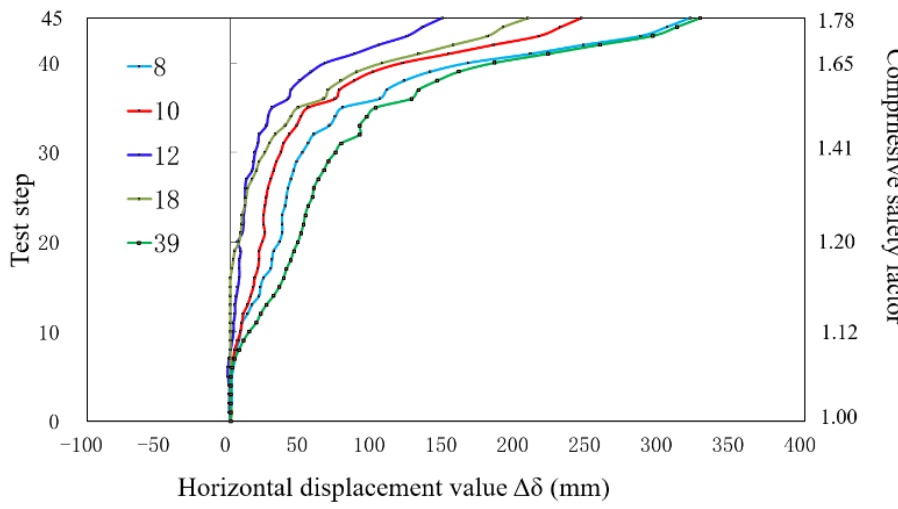
Figure 14. Typical curve of slope surface displacement (monitoring points near concrete plugs).